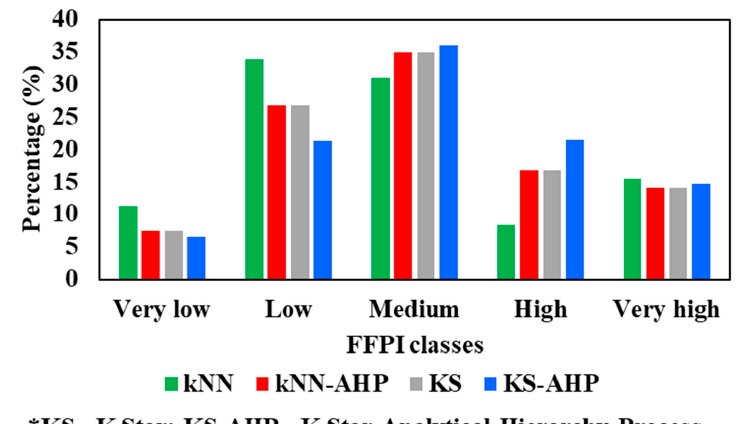
Figure 10. The weights of FFPI classes.